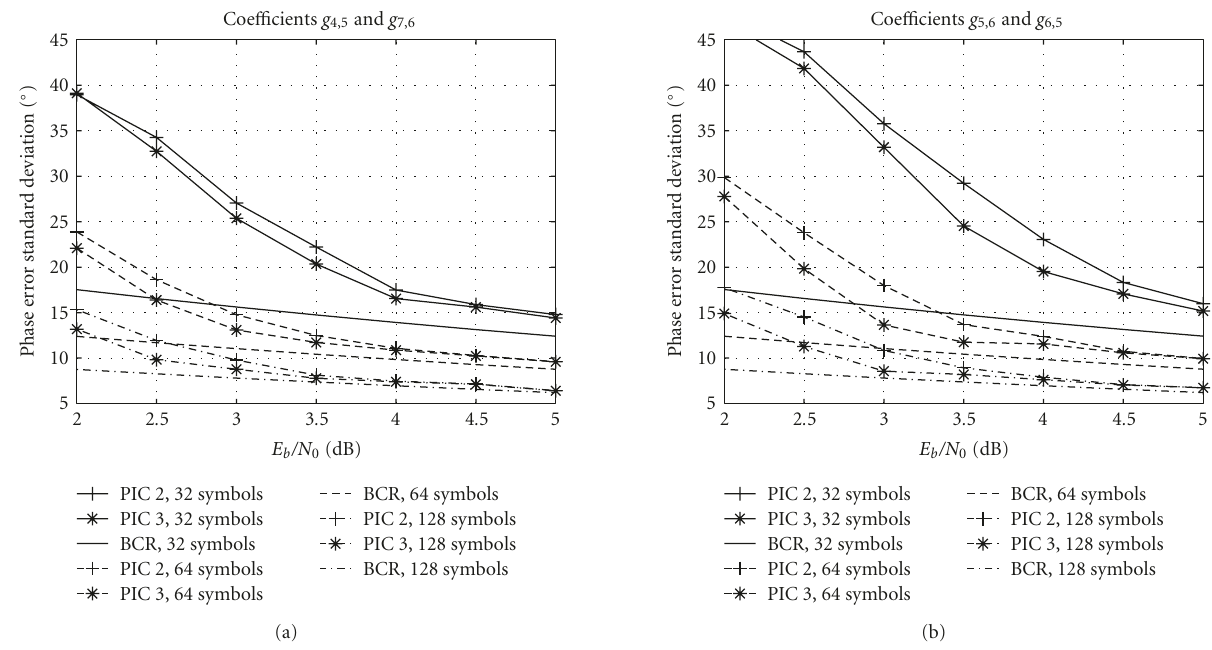
Figure 7: Channel estimation errors for di ff erent coe ffi cients and lengths of window.